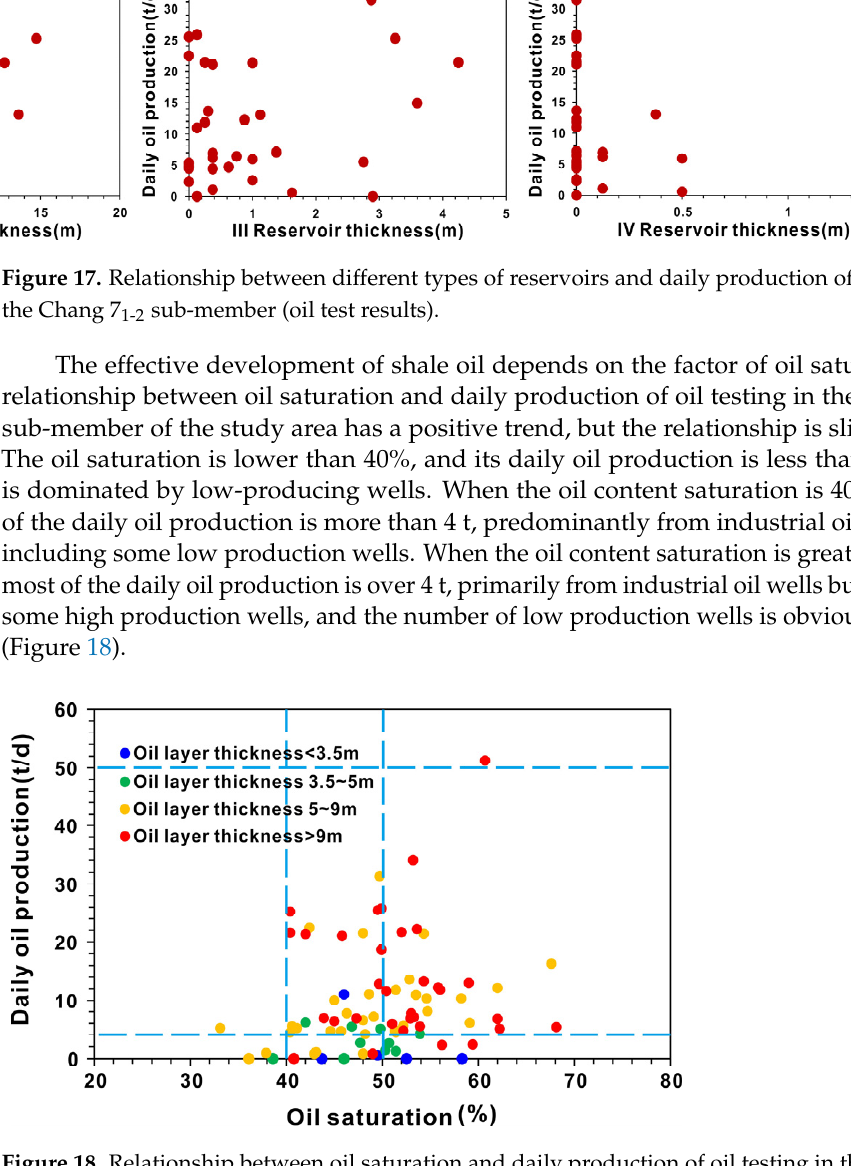
Figure 16. The proportions of various types of reservoirs in different types of oil layers (oil layer, poor oil layer, and dry layer).